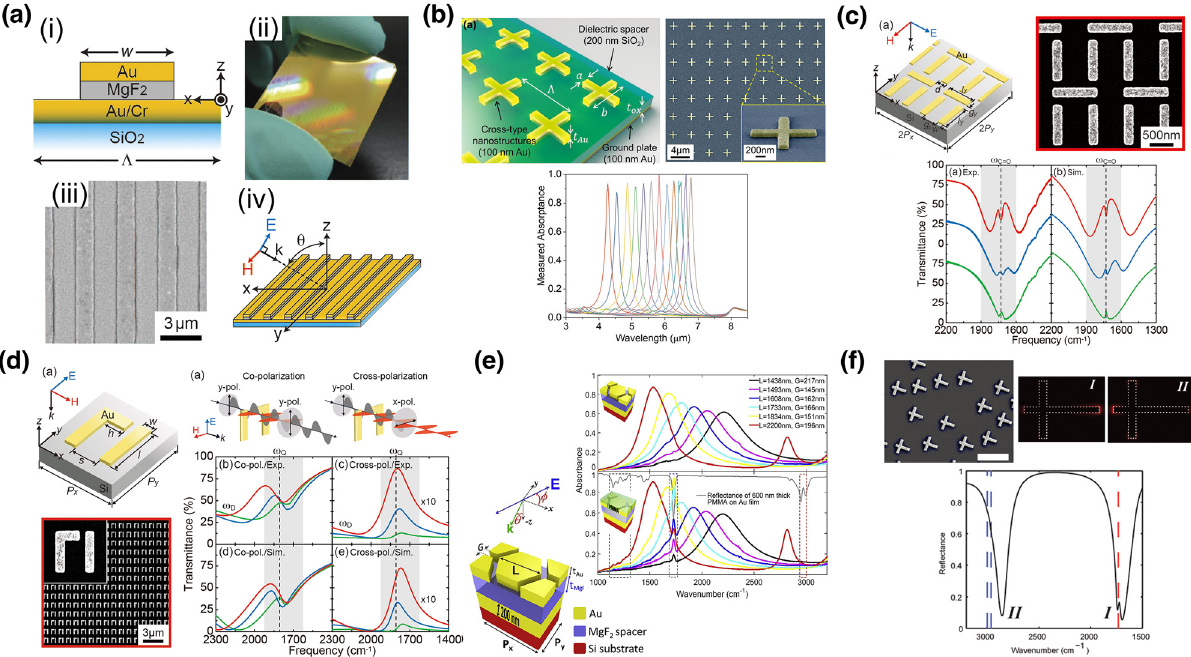
Figure 4: Metamaterial based resonant SEIRA